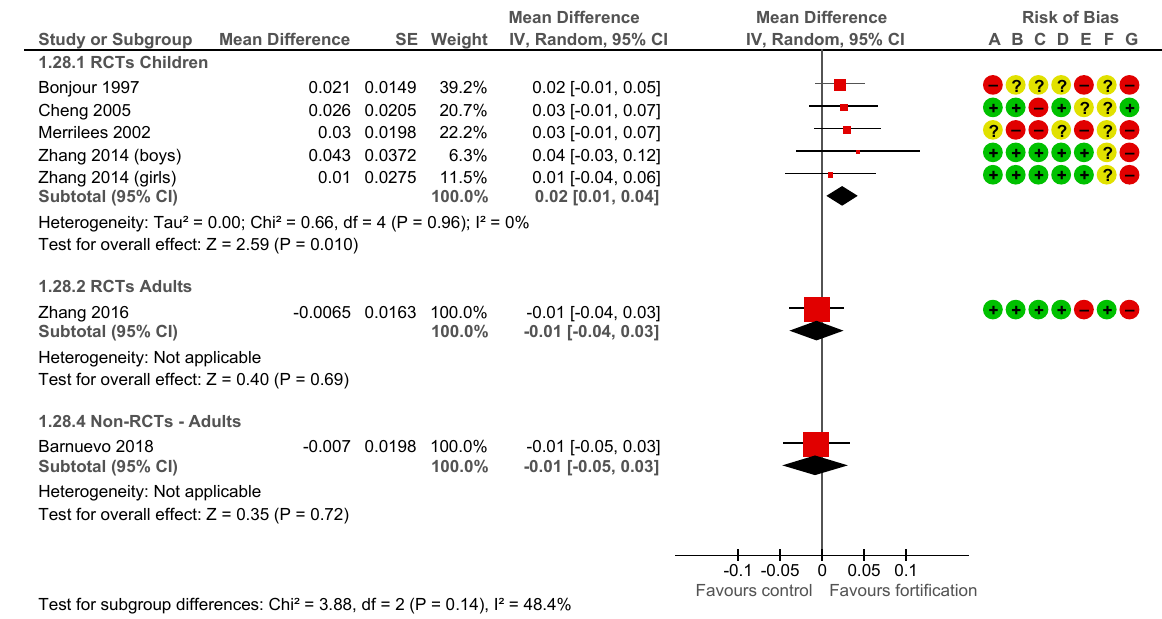
Figure 5. Impact of calcium fortification intervention on BMD femoral Neck (g/cm 2 ). Generic inverse variance [33,34,42,45–47]. The estimated effect of the fortification intervention on BMD Lumbar spine in children was 0.01 g/cm 2 , (95% CI − 0.00 to 0.03, I 2 = 0%) four RCTs with five subgroups and a duration from 11 to 24 months [33,34,42,45], − 0.02 g/cm 2 , (95% CI − 0.06 to 0.02) in postpartum women, one RCT with a duration of 12 months [46] (Figure S8). The estimated effect of the fortification intervention on BMD Lumbar spine in pre- menopausal women was 0.00 g/cm 2 , (95% CI − 0.05 to 0.05) in one Non–RCT study with a duration of 18 months [47] (Figure